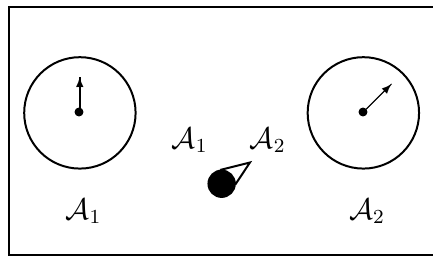
2 selected for A